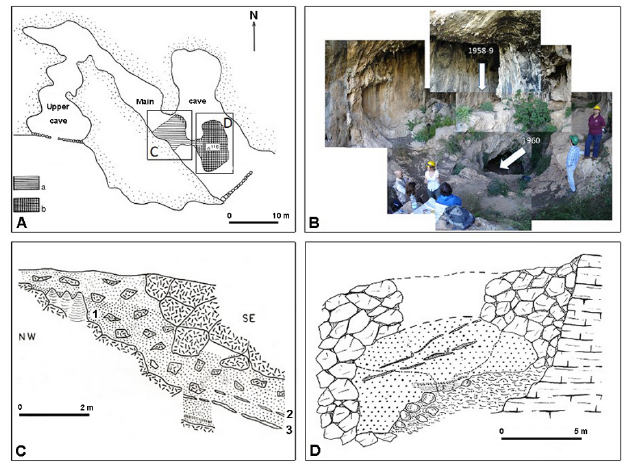
Figure 20. ( A ) Plan of Spinagallo Cave from [64], showing (a) 1958 and (b) 1960 excavation areas. ( B ) Photomontage of the Spinagallo Cave during 2010 field season, showing the excavation areas. ( C ) Section of the area excavated in the 1958 field season, from Ref. [65], showing: 1. the location of ‘the front half’ of a P. falconeri and 2-3: two stalagmitic sheets. ( D ) Section of Spinagallo Cave from Ref. [66] showing the extent of 1958/9 (top) and 1960 excavations, and the presence of two stalagmitic layers. Remnants of these stalagmitic sheets can still be observed on the walls of the lower chamber today.